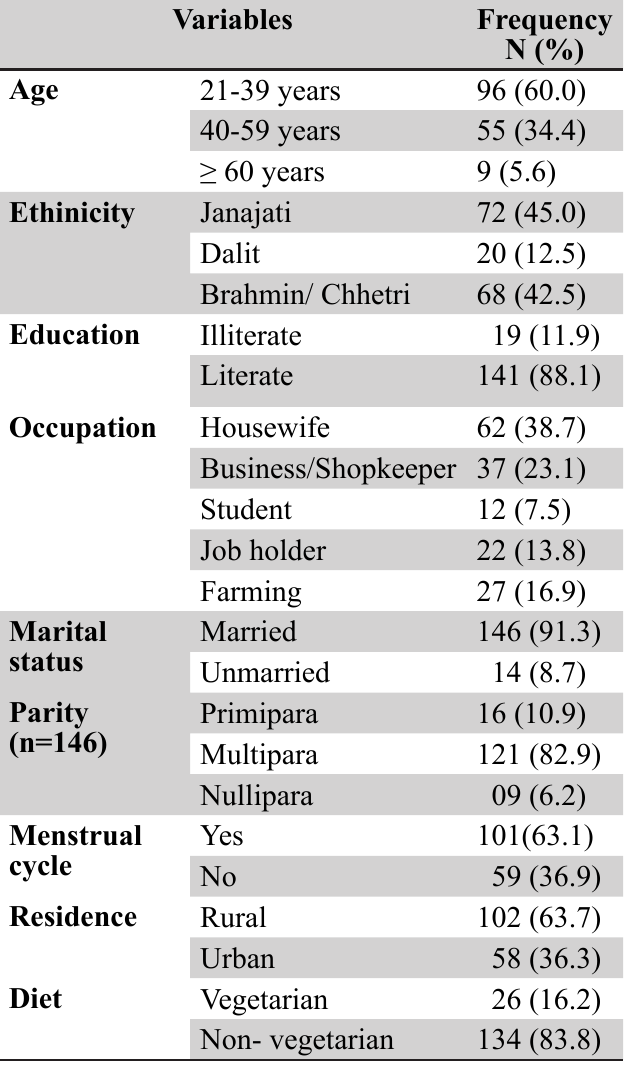
Table 1. Socio-demographic distribution of the study population (N=160)